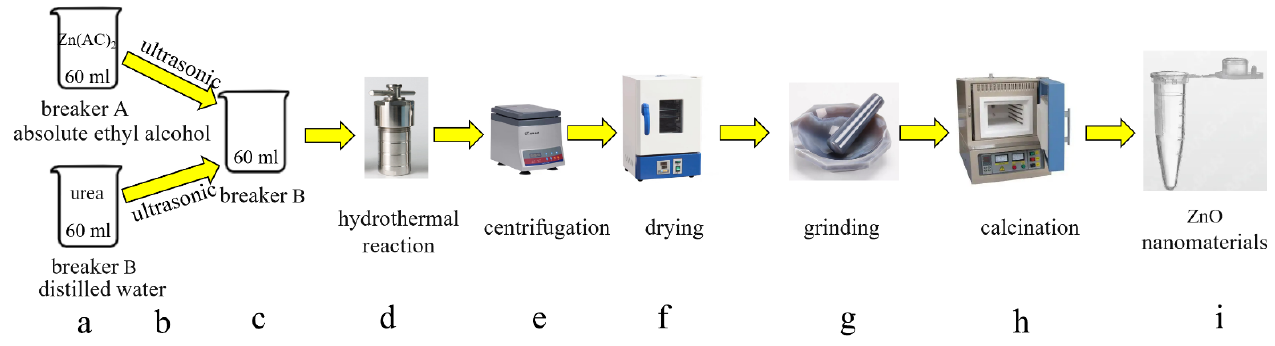
Figure 1. Synthesis of ZnO nanomaterials.